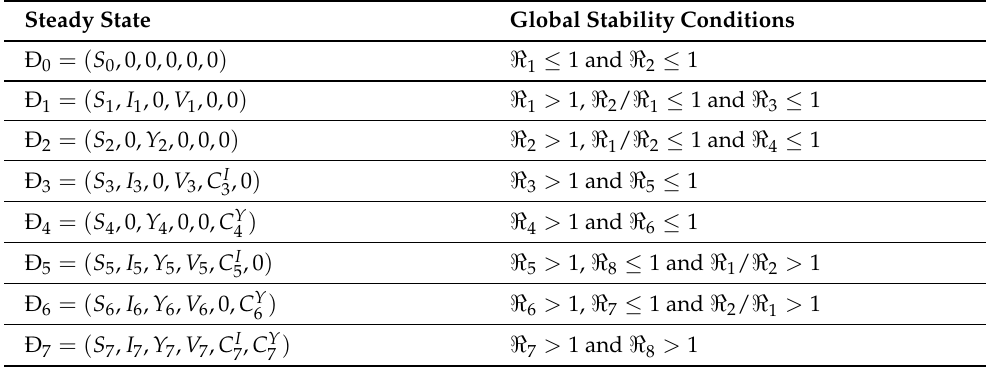
Table 2. Conditions on the global stability of the steady state of model (4). Steady State Global Stability Conditions